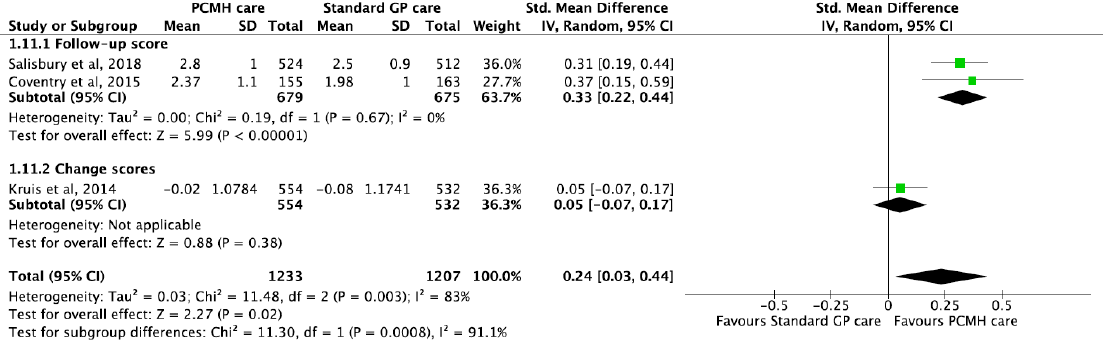
Figure 9. Forest plots of self-management outcomes (Patient Assessment of Care for Chronic Conditions (PACIC) scores) between the PCMH care and Standard GP care .